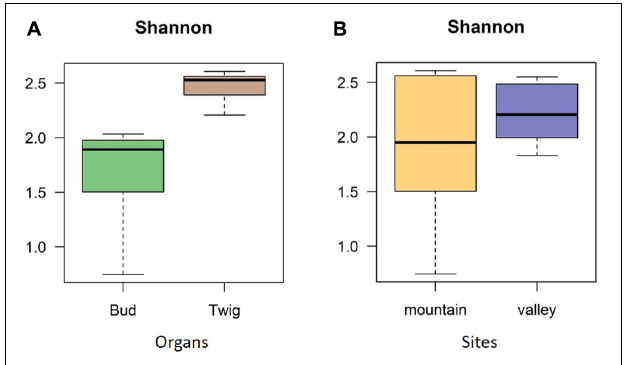
FIGURE 2 | Diversity indices. Shannon diversity indices confirmed mycobiome differences between plant organs (A) but not between sites (B) . The diversity indices investigated differences with respect to species richness and abundance, as indicated by operational taxonomic units (OTUs).